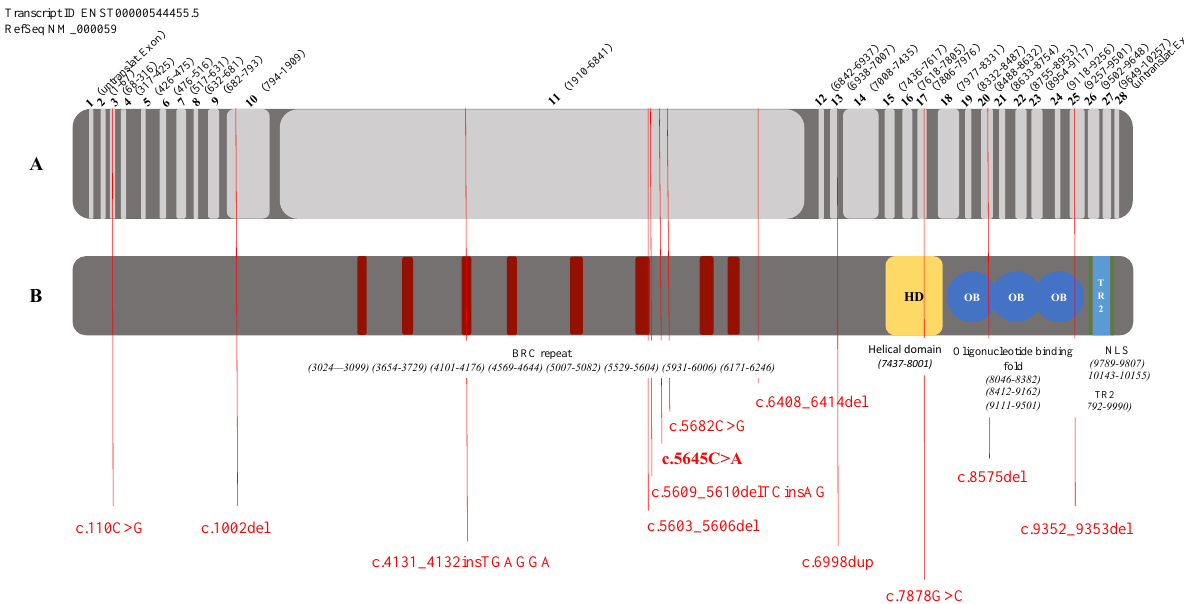
Figure 2. Localization of detected pathogenic variants in the BRCA2 gene (RefSeq NM_000059). ( A ) Gene representation with exon and intron indication (light and dark grey, respectively)—bold numbers: exon numbering; numbers in parentheses: cDNA positions. ( B ) Protein representation—different colored shapes: functional domains; BRC repeat: BRC repeat domain; HD: helical domain; OB: oligonucleotide binding fold; NLS: nuclear localization sequence; TR2: tower domain. Pathogenic variants are indicated in red; bold notation of pathogenic variant: dual occurrence.